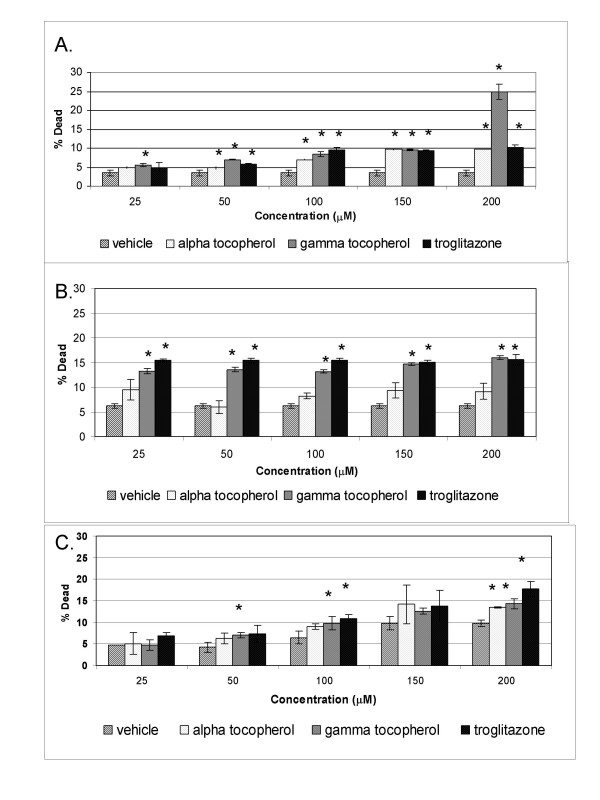
SW480, HCT-116, and HT-29 cells were treated for 5 hours with varying concentrations of tocopherol or the PPAR γ ligand, troglitazone (positive control). The percent of dead cells for SW480 cells (A), HCT-116 cells (B) or HT-29(C) was measured using the Live-Dead assay (Molecular Probes, CA). (Data are representative of three independent trials performed in triplicate. *p < 0.05 vs. vehicle at corresponding concentration.)